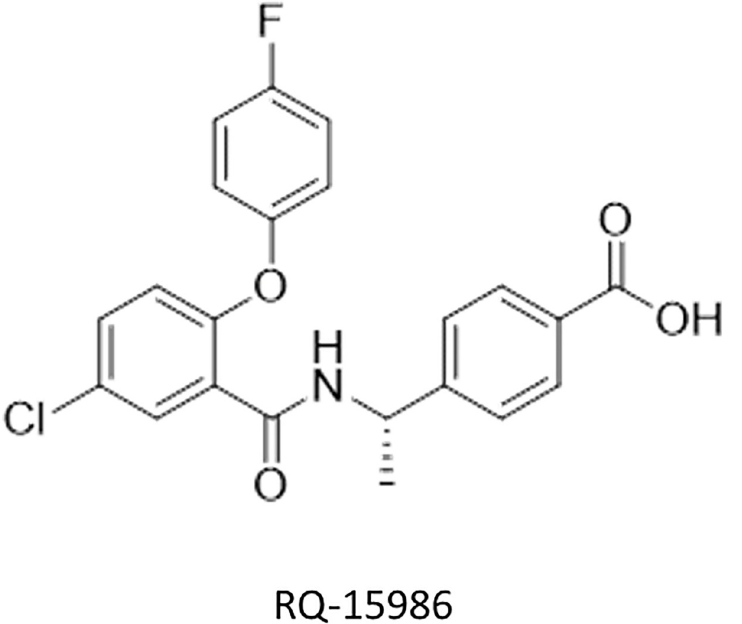
Fig 1. Chemical structure of